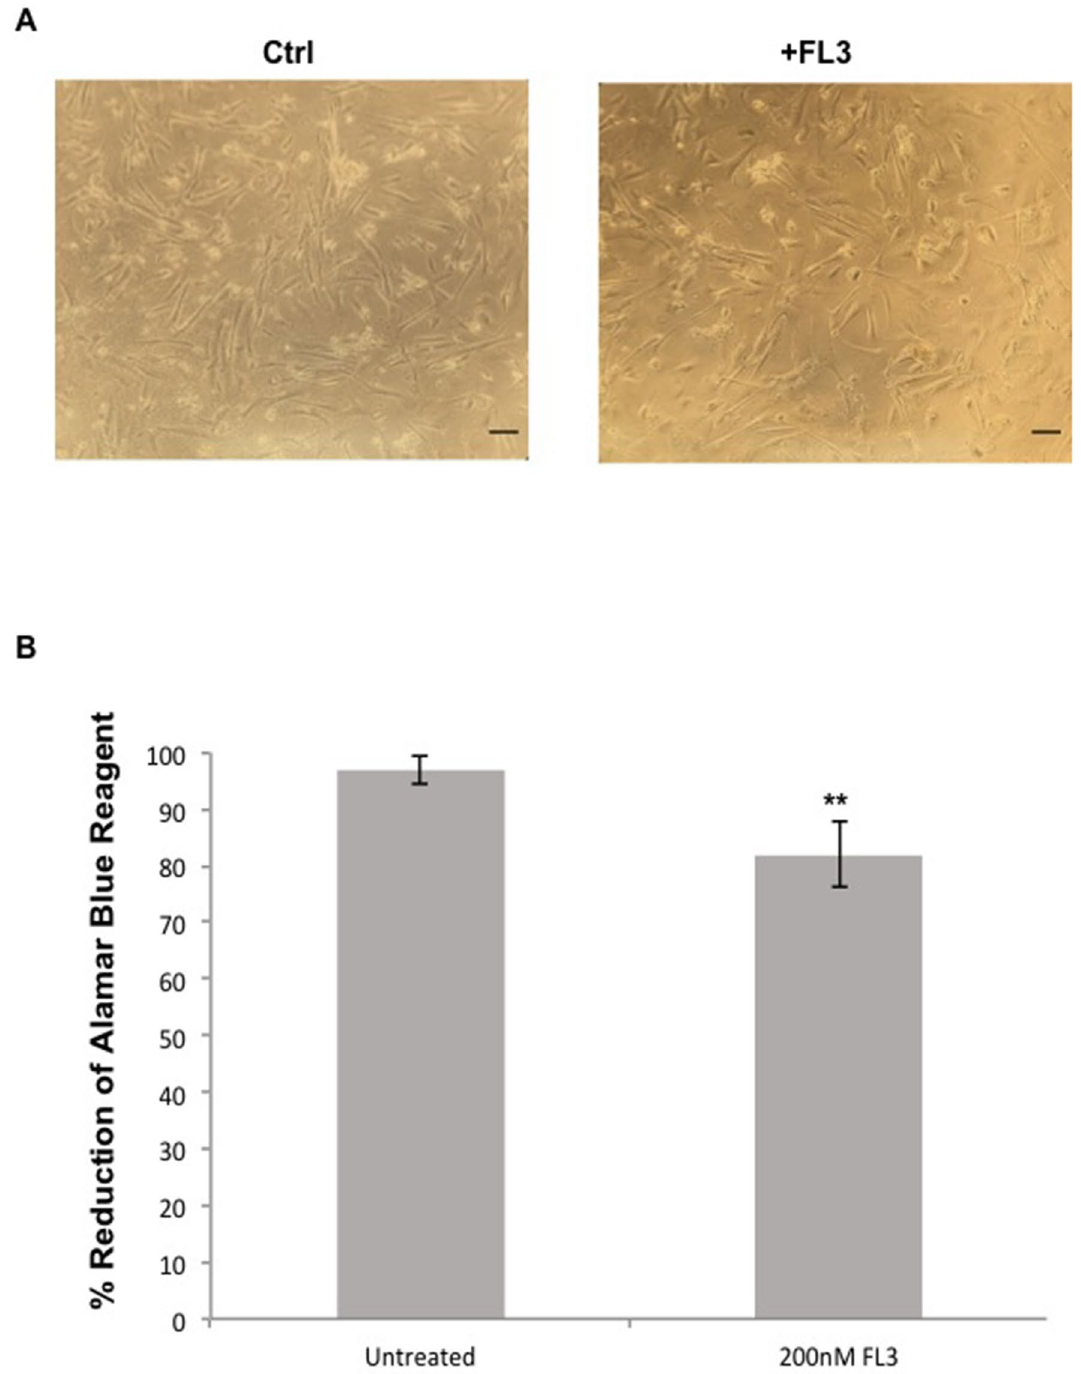
Figure 8. Effect of FL3 on Human brain astrocytes. ( A ) Representative images of control and treated human brain astrocytes with 200 nM FL3. Scale bar represents 100 μm. ( B ) Analysis of cell viability with AlamarBlue assay in human brain astrocytes without treatment and after treatment with 200 nM FL3 respectively. Quantification of mean ± SEM from 3 independent experiments, **P < 0.01 from